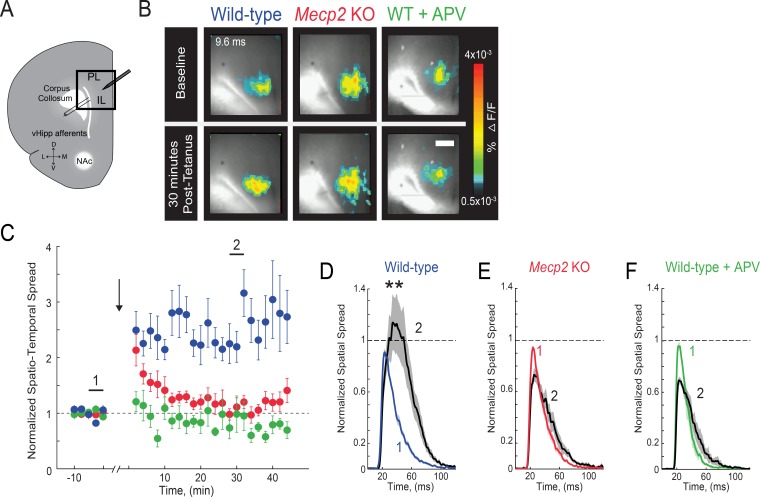
Impaired LTP at vHIP-mPFC synapses in Mecp2 KO mice.(A) Schematic of VSD imaging in an mPFC slice during stimulation of vHIP fibers. (B) Representative images of peak VSD responses to a single pulse stimulation before and after high-frequency stimulation to induce LTP. Scale bar 100 µm. (C) Normalized spatiotemporal spread of single test VSD responses before and after LTP induction; high-frequency stimulation given at arrow. (D–F) Spread over time of single test VSD responses at baseline (1) and 30 min after LTP induction (2), normalized to baseline spread in WT slices (D), Mecp2 KO slices (E), and WT slices in the presence of the NMDA receptor antagonist APV (25 μM) (F) (p=0.0013 Student’s paired t-test, n = 10 slices from 7 WT mice; p=0.2705 Student’s paired t-test, n = 9/5 Mecp2 KO mice; p=0.9205 Student’s paired t-test, n = 4/4 WT mice in APV). Mean ± SEM; *p<0.05, **p<0.01.10.7554/eLife.44182.014Figure 3—figure supplement 2—source data 1.Impaired LTP at vHIP-mPFC synapses in Mecp2KO mice.